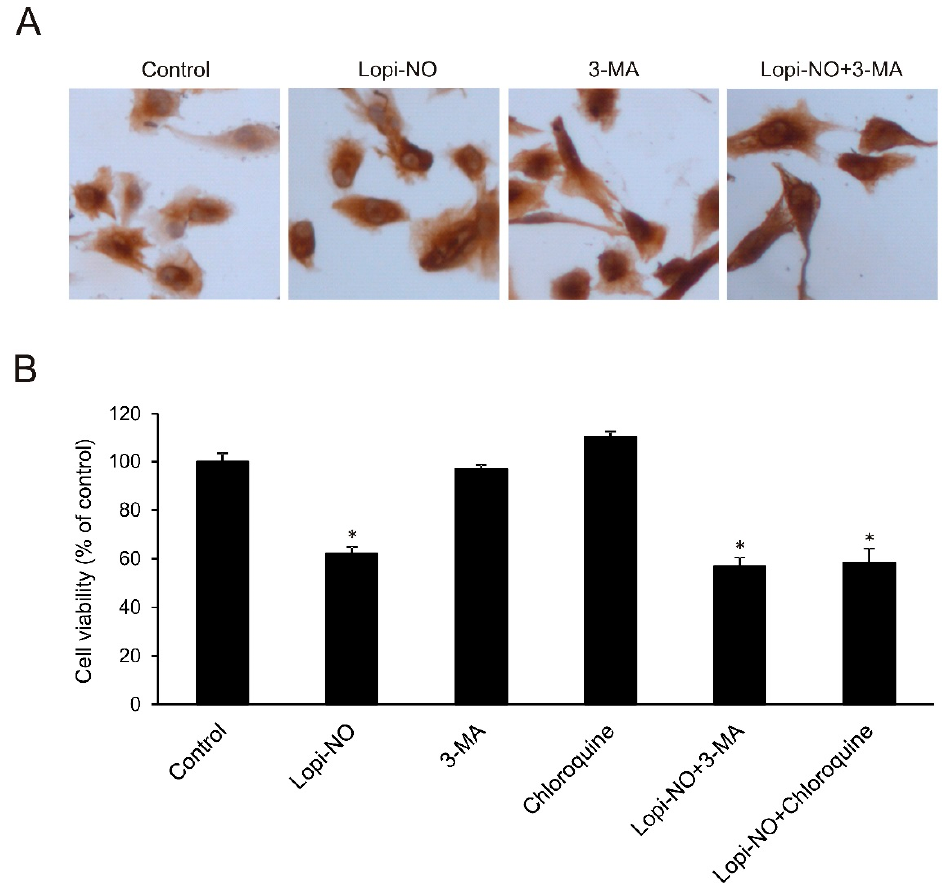
Figure 4. Autophagy is not relevant for differentiation of U-251 induced by Lopi-NO. Cells were treated with the IC 50 value of Lopi-NO in the presence of autophagy inhibitor 3-methyladenine (3-MA) (1 mM) or chloroquine (20 µ M) for 48 h and ( A ) GFAP expression by immunocytochemistry (magnification 320 × ) and ( B ) cellular viability by MTT test were estimated. * p < 0.05 refers to untreated